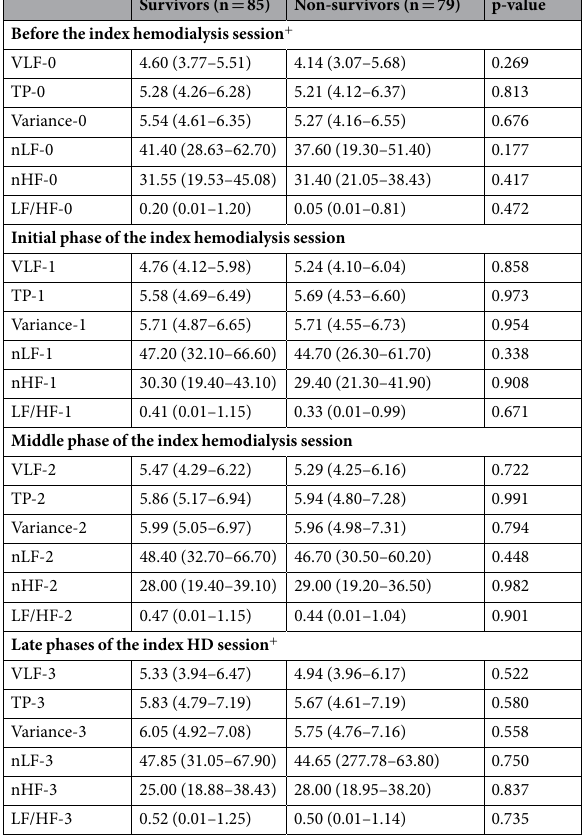
Table 2. Comparisons of the heart rate variability indices between survivors and non-survivors at 8-year follow-up. Notes: Values are presented as median (interquartile range). P-value was calculated using an independent Student’s t -test. HRV-0, -1, -2, and -3 were HRV measured before hemodialysis, and at initial, middle, and late phases of the index hemodialysis session, respectively. Units: Ln (ms 2 ) in VLF, TP, and Variance; Ln (ratio) in LF/HF ratio; normalized unit in nLF and nHF. Abbreviations: Ln, nature logarithmical; nHF, normalized high-frequency; nLF, normalized low-frequency; TP, total power; Variance, the variance of the R-R intervals; VLF,